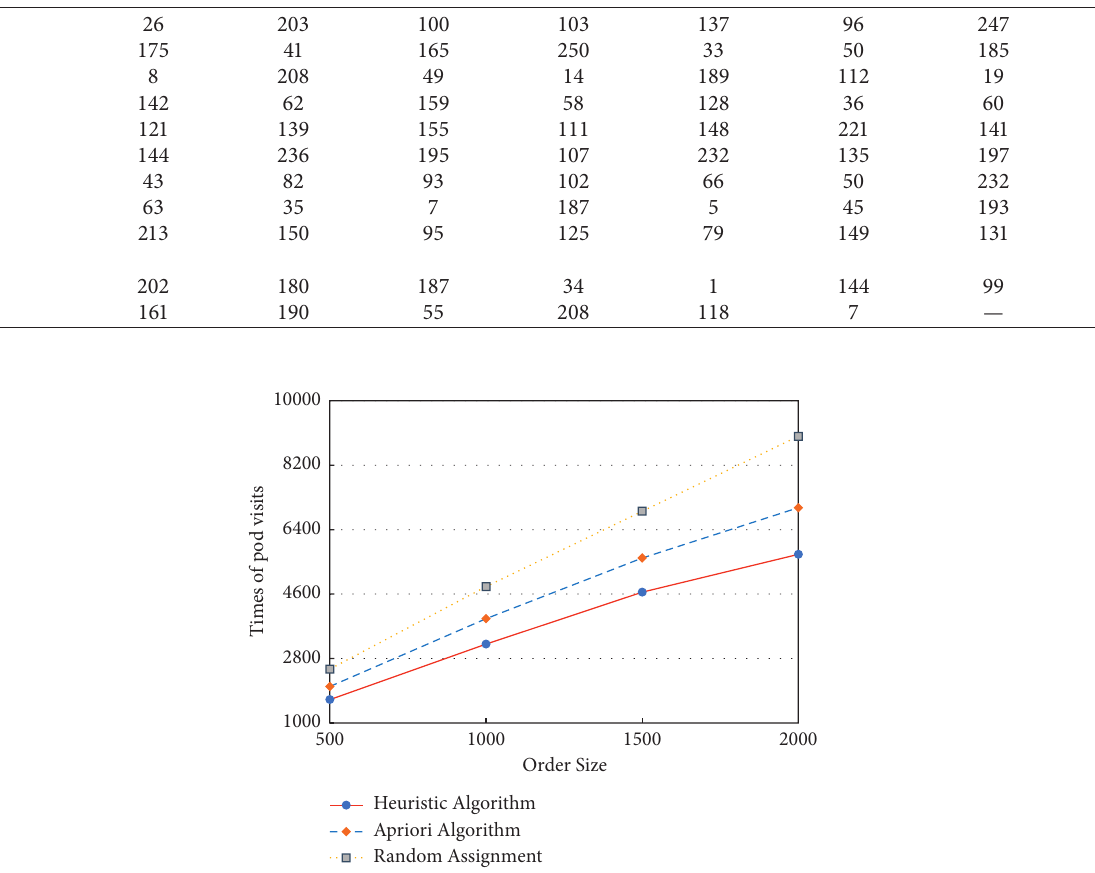
Figure 2: Times of pod visits using different algorithms.